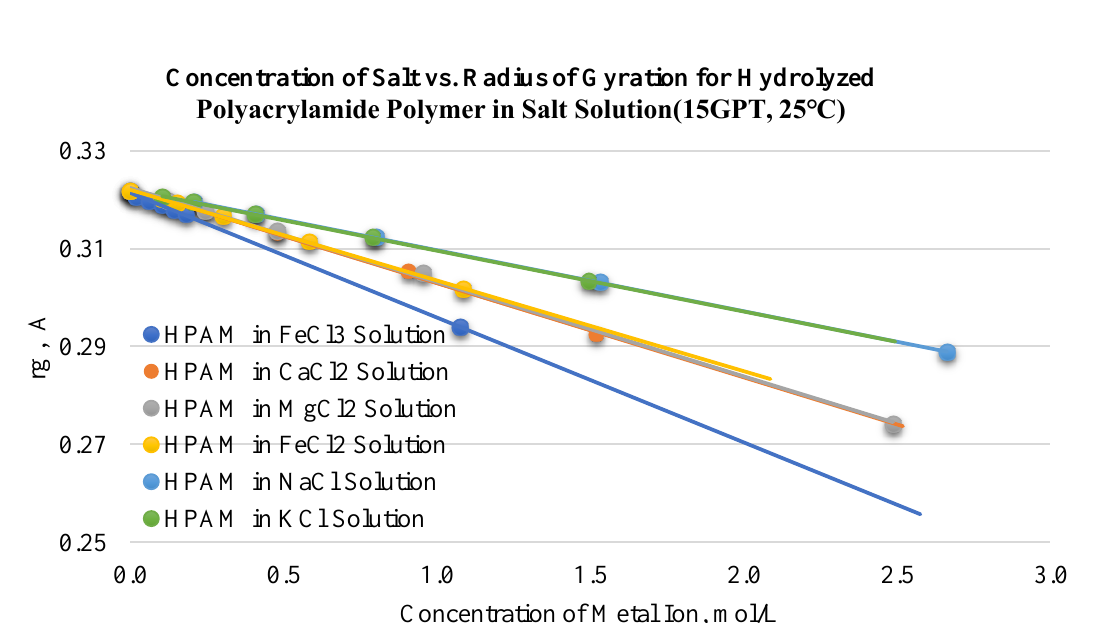
Figure 9—HPAM polymer with 4-repeat units.